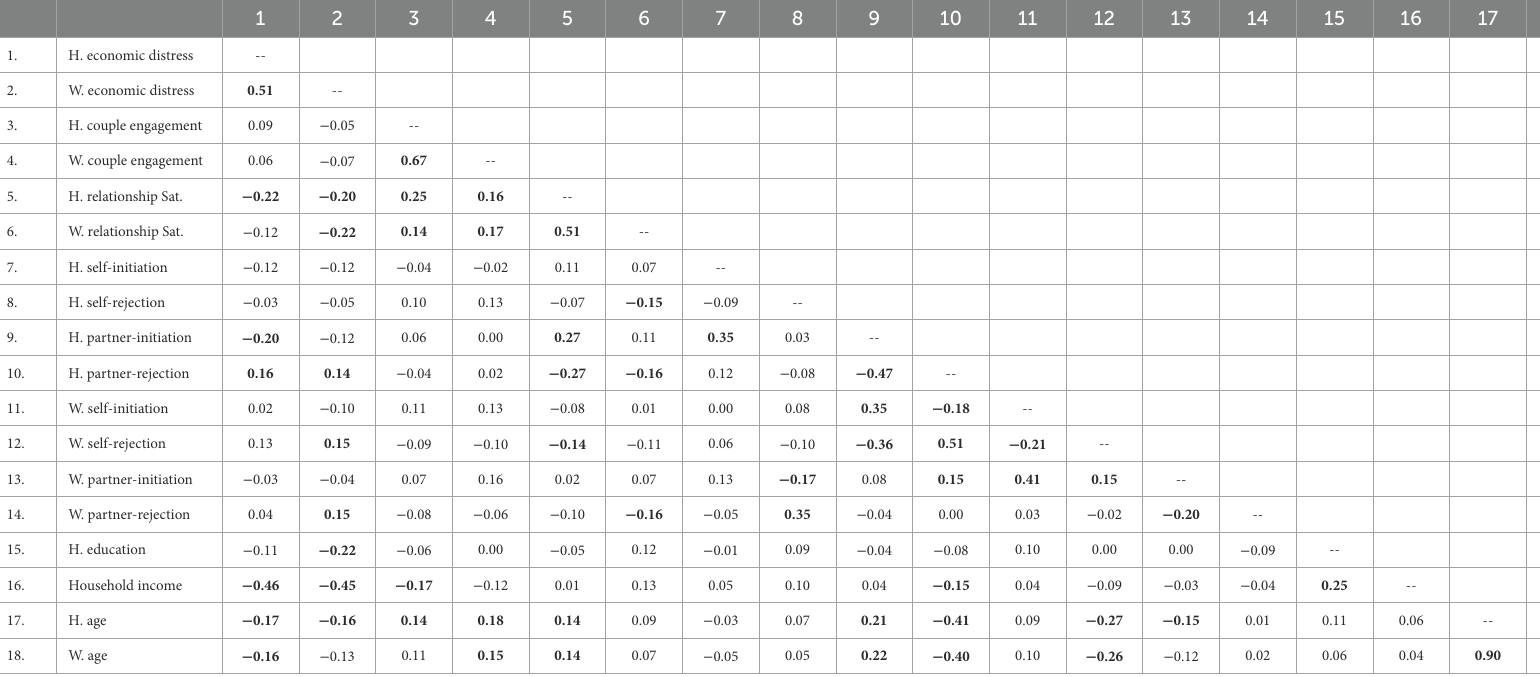
TABLE 1 Bivariate correlations, M, and SD among the observed